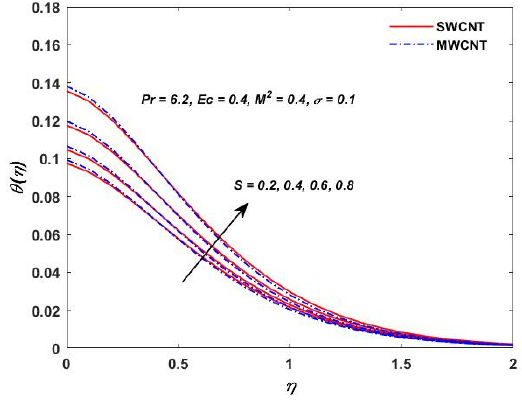
Figure 14. Rotation verses 𝜃(𝜂).